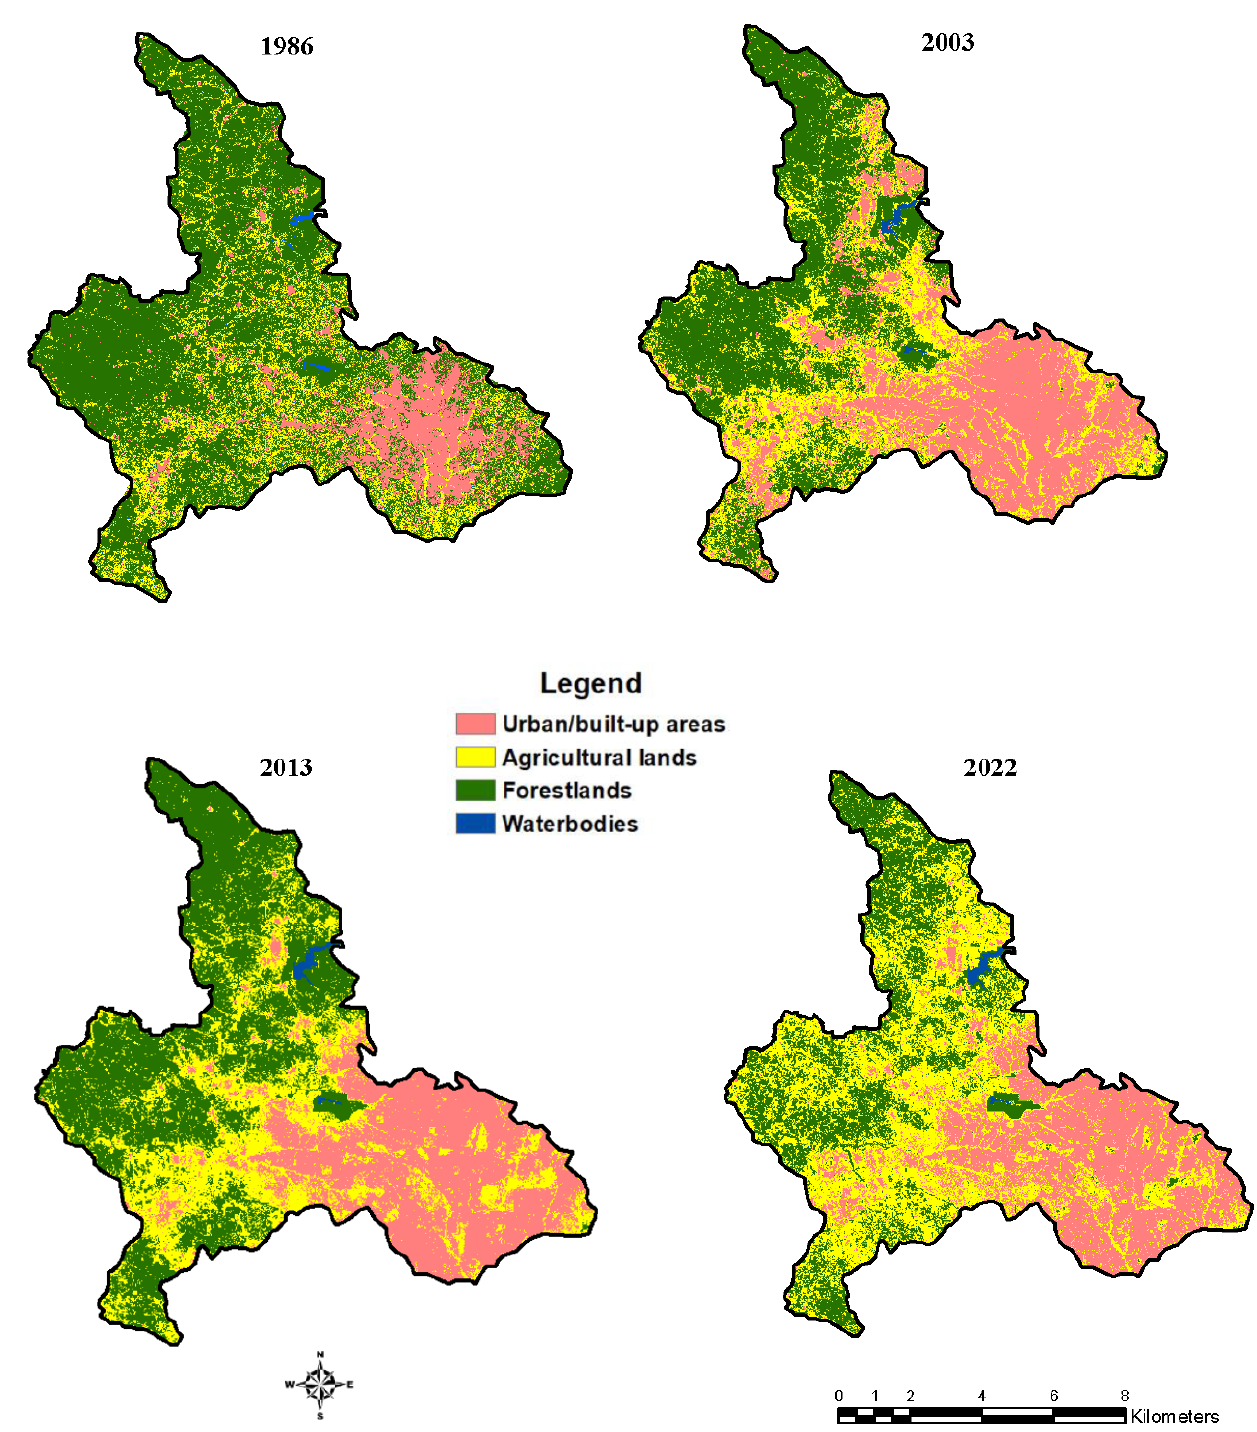
Figure 5. Land use land cover maps (1986, 2003, 2013, and 2022). The urban/built-up areas that covered approximately 15% in 1986 increased to 30.68% in 2022. Agricultural lands increased from 19.47% in 1986 to 42.71% in 2022. For- estlands that covered 65.15% in 1986 were reduced to 26.17% in 2022. On the other hand, the smallest changes in the LULC were observed for the waterbodies, as a slight increase was observed from 0.33% (1986) to 0.44% (2022) (Table 3).